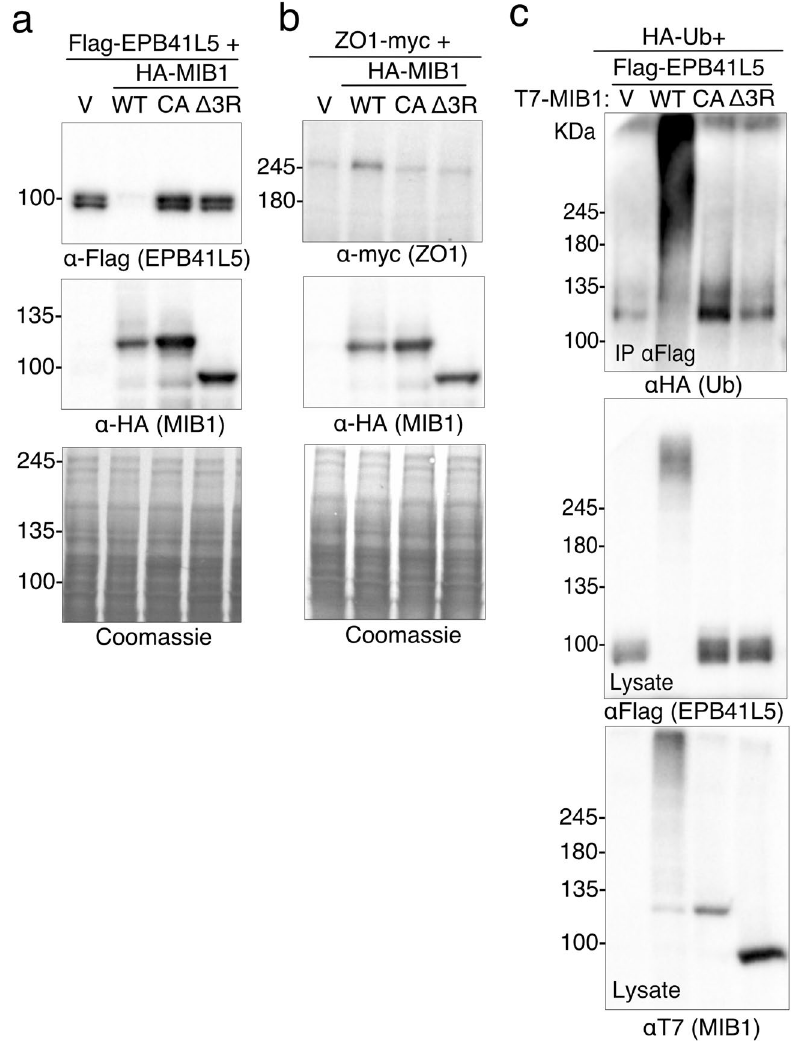
Figure 4. MIB1-mediates ubiquitination and degradation of the polarity protein EPB41L5. ( a , b ) HEK293T cells were transiently co-transfected with FLAG-EPB41L5 or ZO1-myc, and HA-MIB1 WT or RING mutant (HA-MIB1CA or HAMIB1 Δ 3R). Eighteen hours following transfection, 50 μ g of cell lysates were resolved by SDS-PAGE and immunoblotted with anti-FlagM2 ( a , EPB41L5), anti-myc ( b , ZO1), or anti-HA (MIB1). ( c ) EPB41L5 is ubiquitinated by MIB1. HEK293T cells were transiently co-transfected with Flag-EPB41L5, HA- ubiquitin and either T7-MIB1WT, T7-MIB1CA, or T7-MIB1 Δ 3R. Eighteen hours post-transfection, cells were treated for 4 hours with 10 μ M MG132, and cell lysates prepared in 1%SDS/RIPA lysis buffer. Flag-EPB41L5 was immunoprecipitated from 2 mg of the protein lysate with anti-FlagM2 and immunoblotted with anti-HA to detect ubiquitinated proteins (Top). Lysates (50 μ g) were probed with anti-FlagM2 (middle) and anti-T7 (bottom panel) to confirm expression of EPB41L5 and MIB1. Each figure is representative of at least 3 independent experiments. For clarity some blots were cropped. Full length blots are shown in Supplementary Fig.